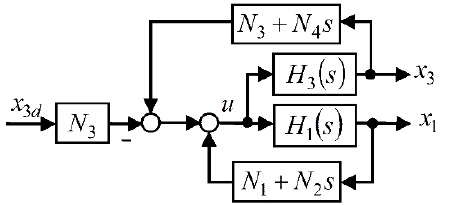
Figure 2. State-feedback linearized CIP control system.